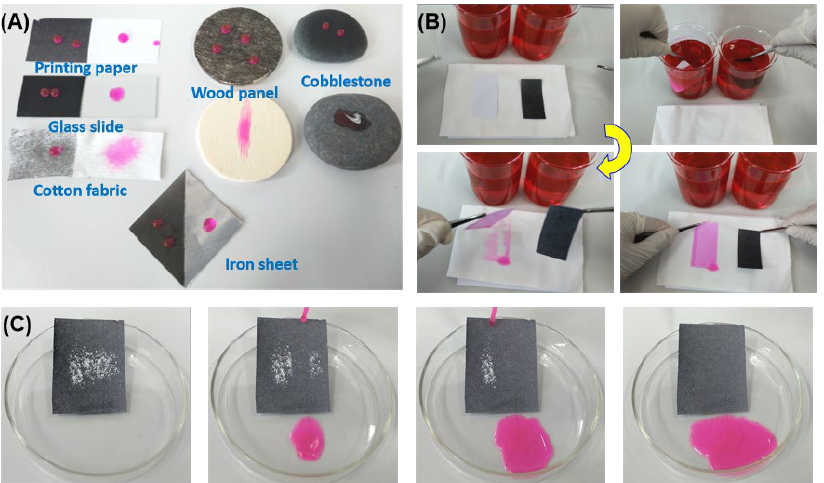
Figure 3. ( A ) Wetting behaviors of various substrates with/without electrosprayed PVDF/CS coat- ings by placing some 12 μL water droplets (dyed red) on them; ( B ) wetting behaviors of double-faced superhydrophobic printing paper (coated with the same coatings as ( A )) and the uncoated paper, when they are first immersed into the red water and then placed on the cotton; ( C ) snapshots showing the self-cleaning property of the coated printing paper by slowly dropping water droplets on the surface which has been sprinkled with the chalk powder.